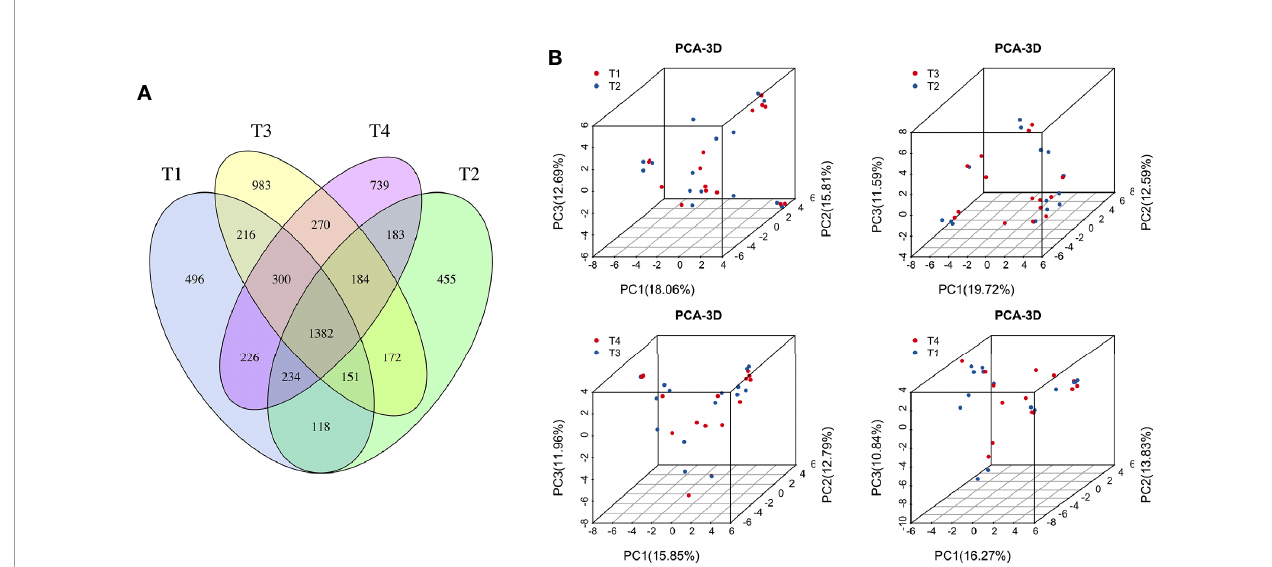
FIGURE 2 | (A) Venn diagram for the integration among the four time points of patient samples. (B) 3D scatter plot of PCA results for comparison among four time points of patient samples (T1 vs T2, T3 vs T2, T4 vs T3, and T4 vs T1). T1, the fi rst time point sample; T2, the second time point sample; T3, the third time point sample; T4, the fourth time point